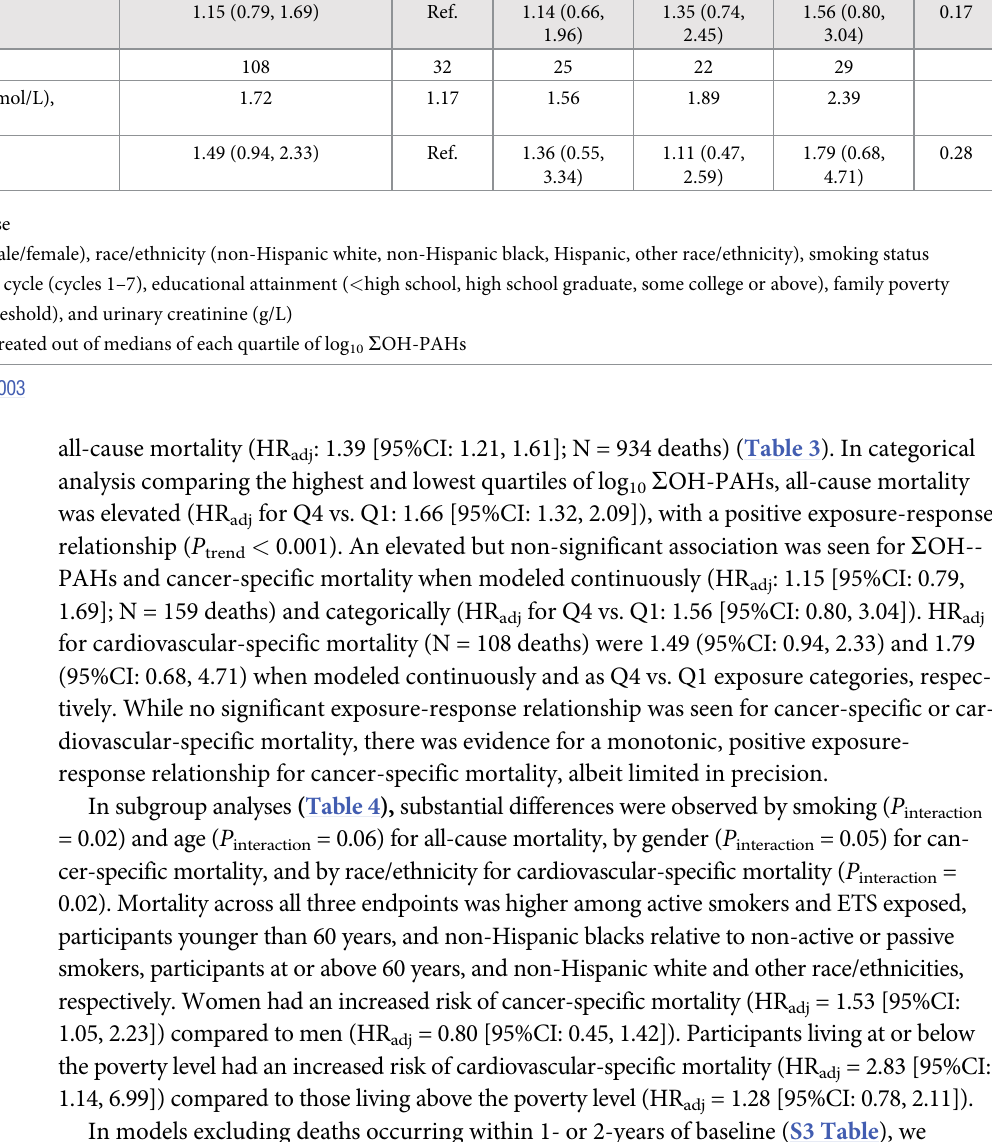
Table 3. Association between log-transformed S OH-PAHs (nmol/L) and all-cause, cancer-specific, and CVD-specific mortality, adjusted for covariates a . Mortality type